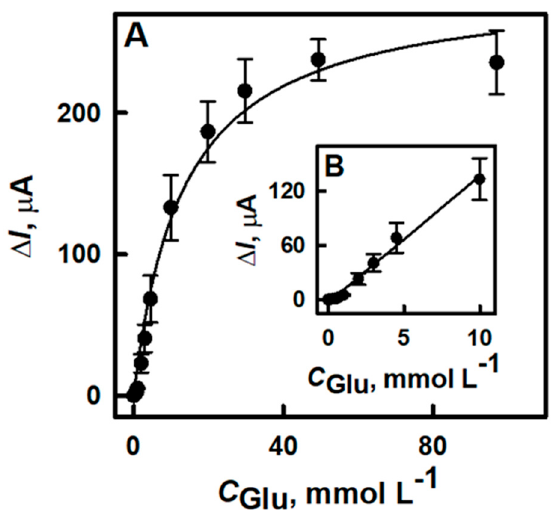
Figure 7. Calibration plot of glucose biosensors based on DGNs electrochemically deposited on the electrode at optimal conditions ( A ) and linear glucose detection interval ( B ). Amperometric response was measured in 0.05 mol L − 1 SA.